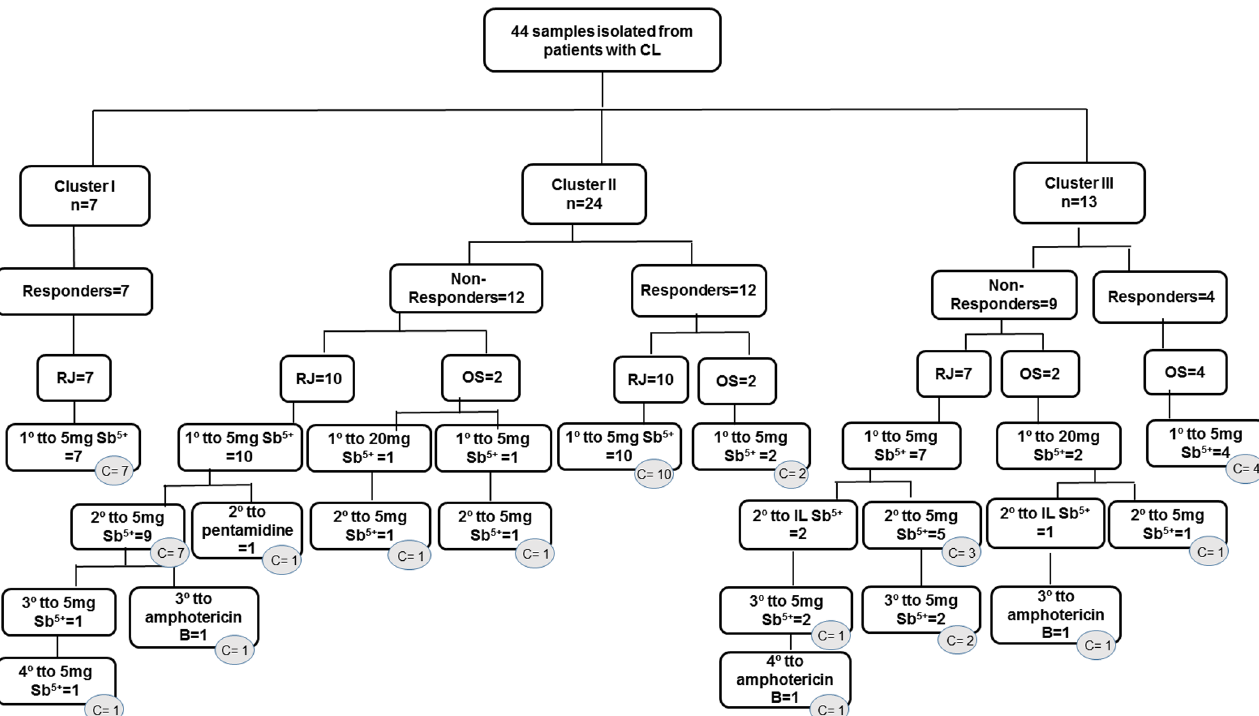
Figure 1. Illustrative fl ow diagram of treatments administered to groups of 44 cutaneous leishmaniasis patients classi fi ed by Leishmania (Viannia) braziliensis clusters, by type of therapeutic response to one treatment course and by localization of infection. Circles fi lled in gray indicate the treatment (one course or additional ones) that promoted patient cure. RJ= Rio de Janeiro; OS=other states; tto= treatment, IL= intralesional; C=